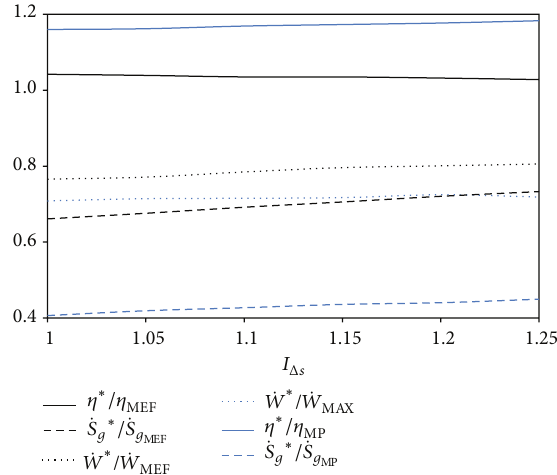
Figure 5: Comparisons of the optimum performances at ECOP ̇𝑊 ̇𝐸 and with respect ̇𝐸 ̇ 𝑊 , and conditions based on 𝐼 Δ𝑆 for 𝜏 = 7 ( 𝑇 0 = 𝑇 𝐿 = MAX MAX 300 K, 𝑋 = 0.3 , and 𝜉 = 0.02